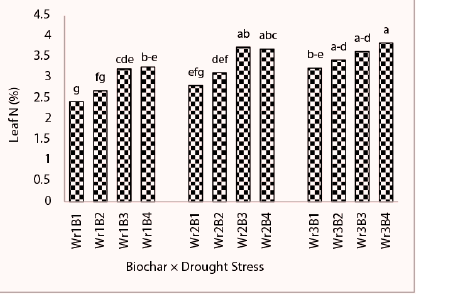
Figure 1 The effects of the interaction of drought stress and biochar on N content of melon leaf. Mean values with the same letters are not significantly different at p ≤ 0.05 according to LSD test.